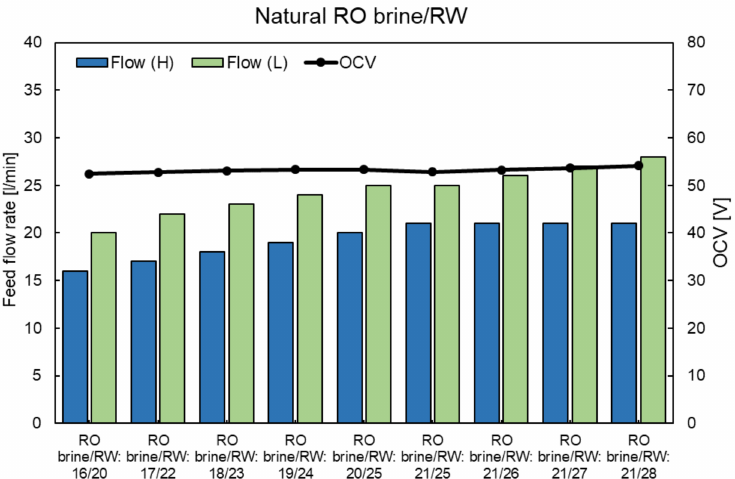
Figure A5. OCVs of RED stack using the natural RO brine and RW feed solution at different feed flow